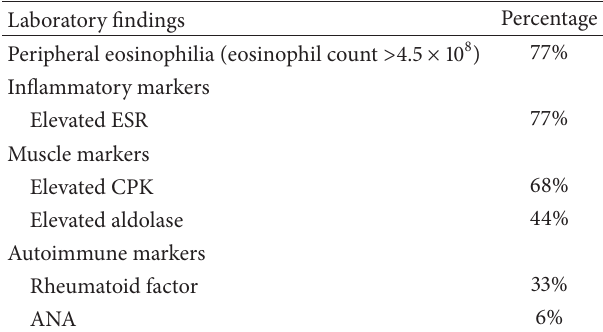
Table 2: Laboratory findings of eosinophilic myositis [18]. Laboratory